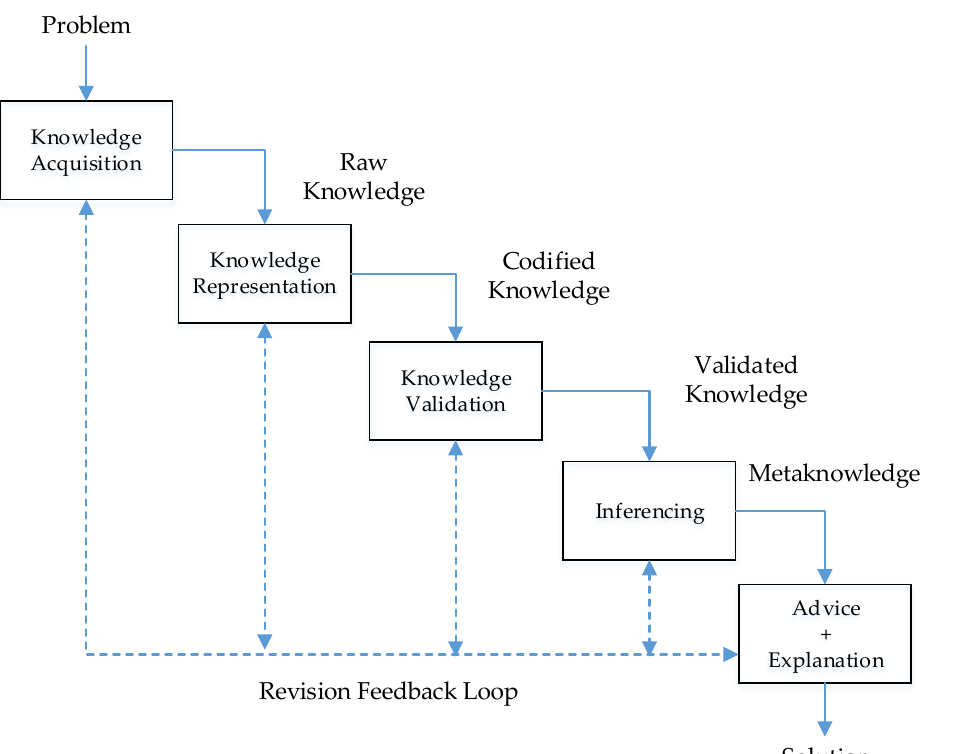
Figure 2. The process of knowledge engineering (adapted).